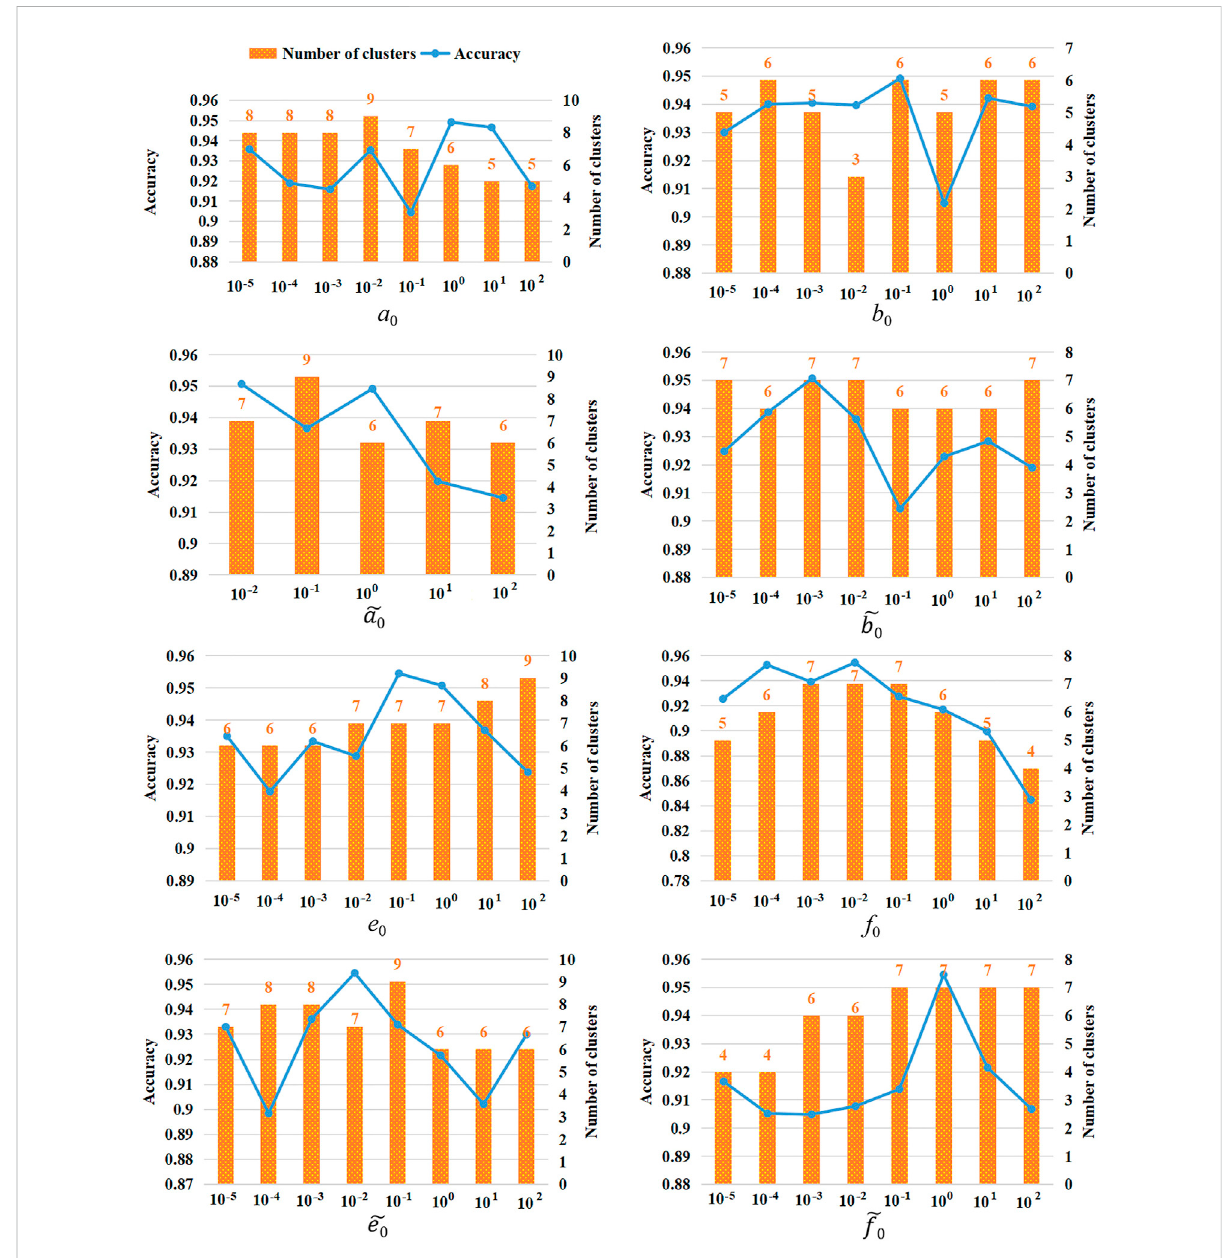
FIGURE 6 The recognition effects on the